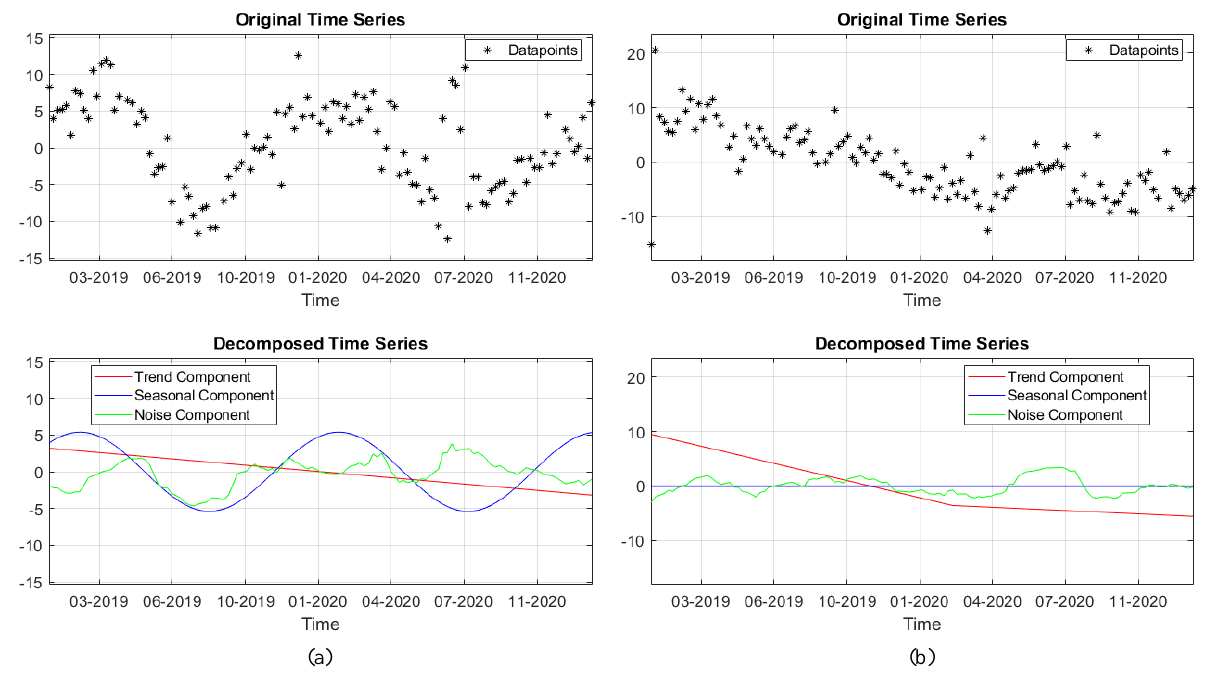
Figure 9 . The original and decomposed time series of PS 2 (a) and 3